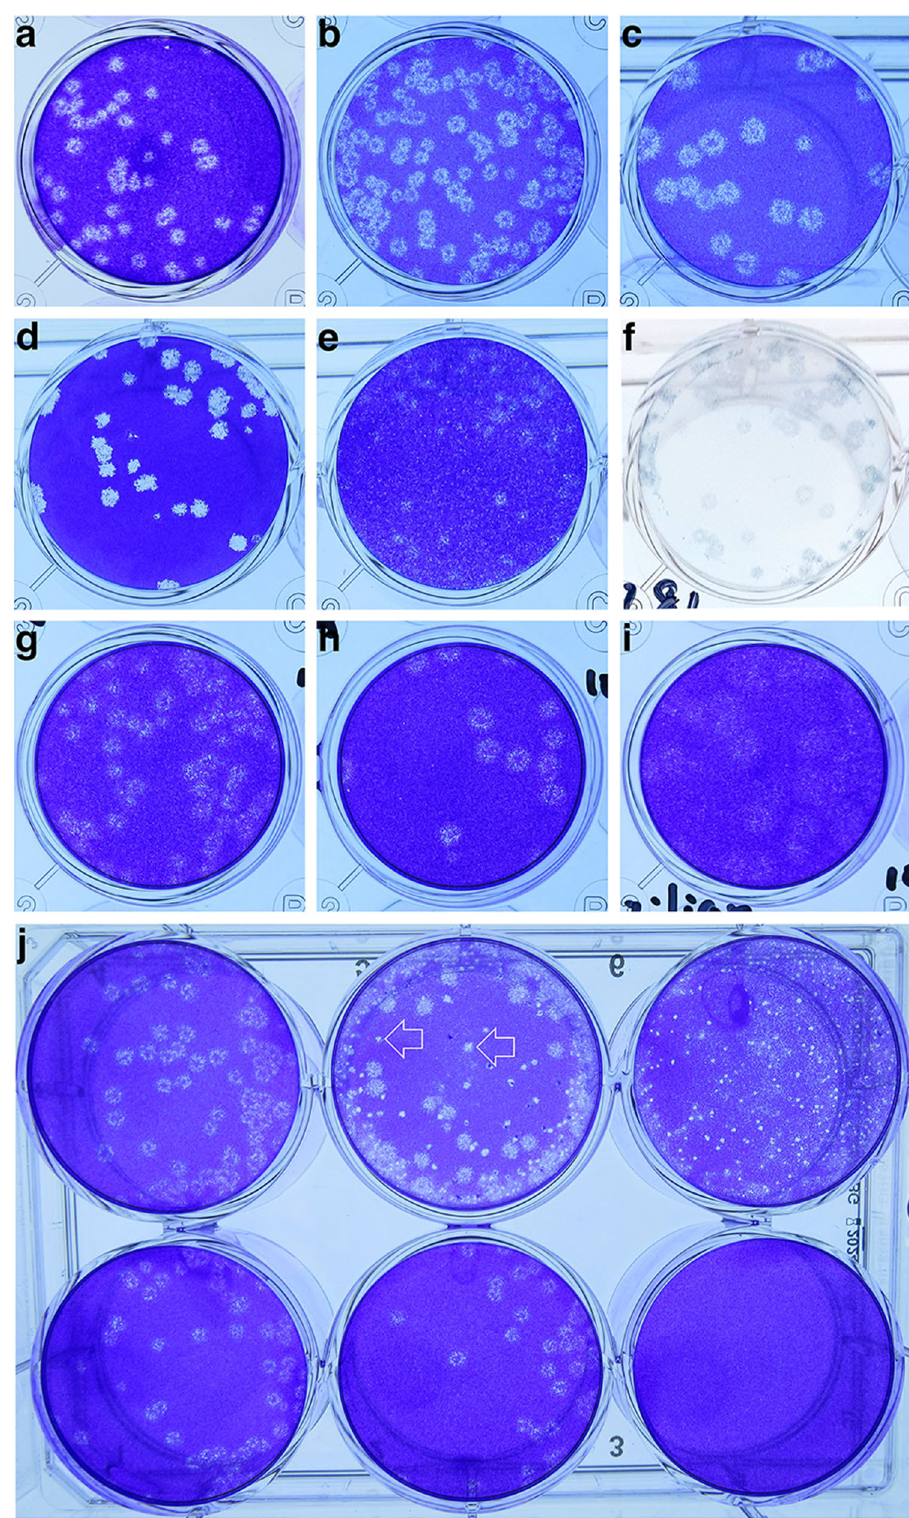
Figure 1. SARS-CoV-2 plaque morphology. ( a–c ) Variation in plaque sizes when clinical samples are plated on Vero CCL-81 cells. Note the characteristic halo structure. ( d ) SARS-CoV-2 plaques on Vero E6/TMPRSS2 cells. ( e–f ) SARS-CoV-2 plaques on CCL-81 cells stained with crystal violet ( e ) and immunohistochemical staining with an anti-SARS-CoV-2 spike antibody ( f ). ( g–i ) SARS-CoV-2 variants of concern on Vero CCL81 cells ( g : Alpha; h : Beta; i : Gamma). j Patient samples passed through 0.2 mm filters to remove bacterial and fungal contamination. Top row: unfiltered samples; Bottom row: filtered samples. Arrows show examples of false plaques caused by growth of bacteria/fungi on the cell monolayers. Figure prepared using Photoshop v23.0 (https:// www. adobe.